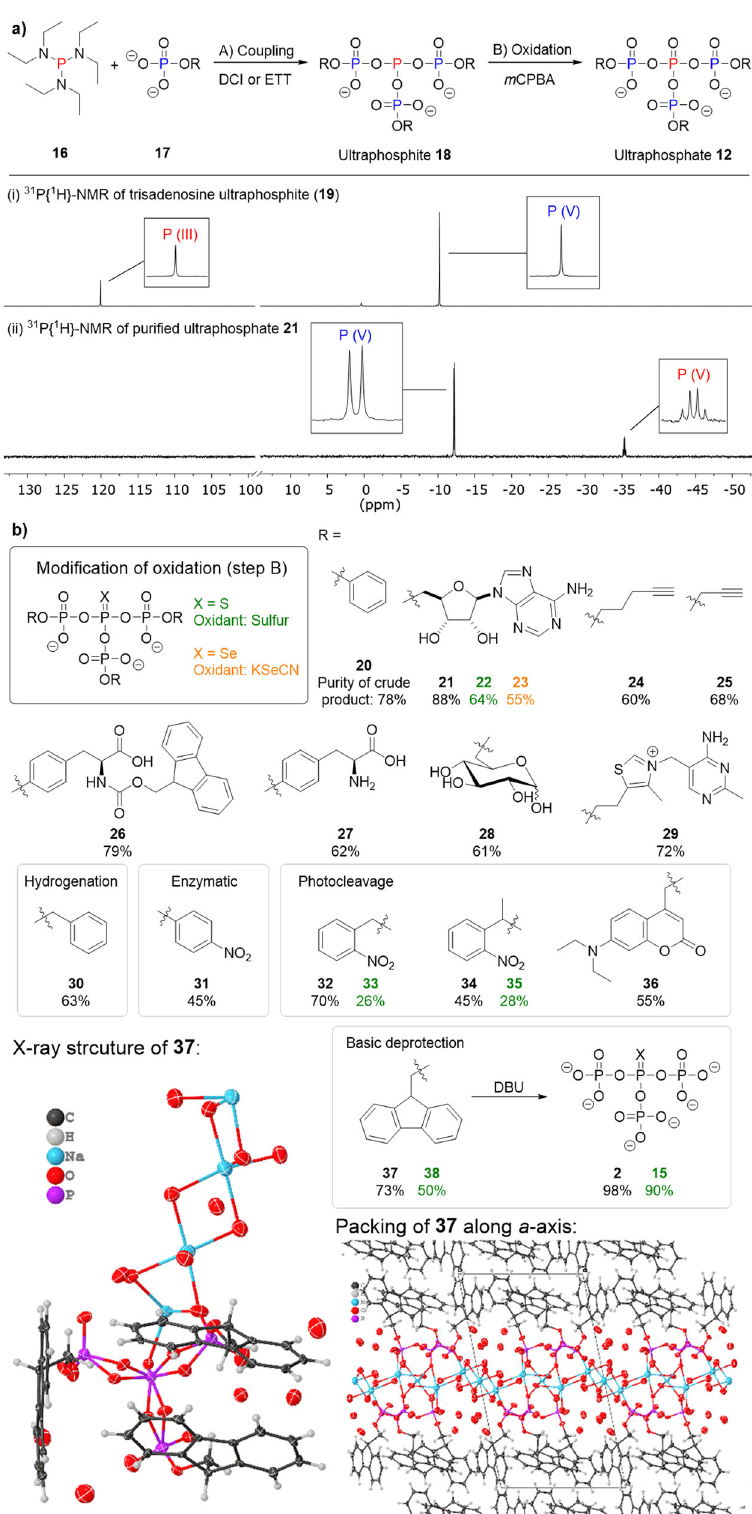
Fig. 2 Symmetrical ultraphosphates. a Synthesis of ultraphosphates by threefold coupling of phosphates with tris(diethylamino)phosphine 16 and subsequent oxidation. 31 P{ 1 H}-NMR spectra of the intermediary ultraphosphite 19 and the ultraphosphate 21 after oxidation and puri fi cation for R = adenosine. b Synthetic scope of the synthesis of symmetrically modi fi ed ultraphosphates and modi fi cation of the oxidation step to yield thio- and seleno analogues. The purity of the crude products is given in percent according to the 31 P{ 1 H}-NMR spectra. Yields were not determined due to uncertain quantities of counterions but the respective crude masses are reported in the supporting information along with the